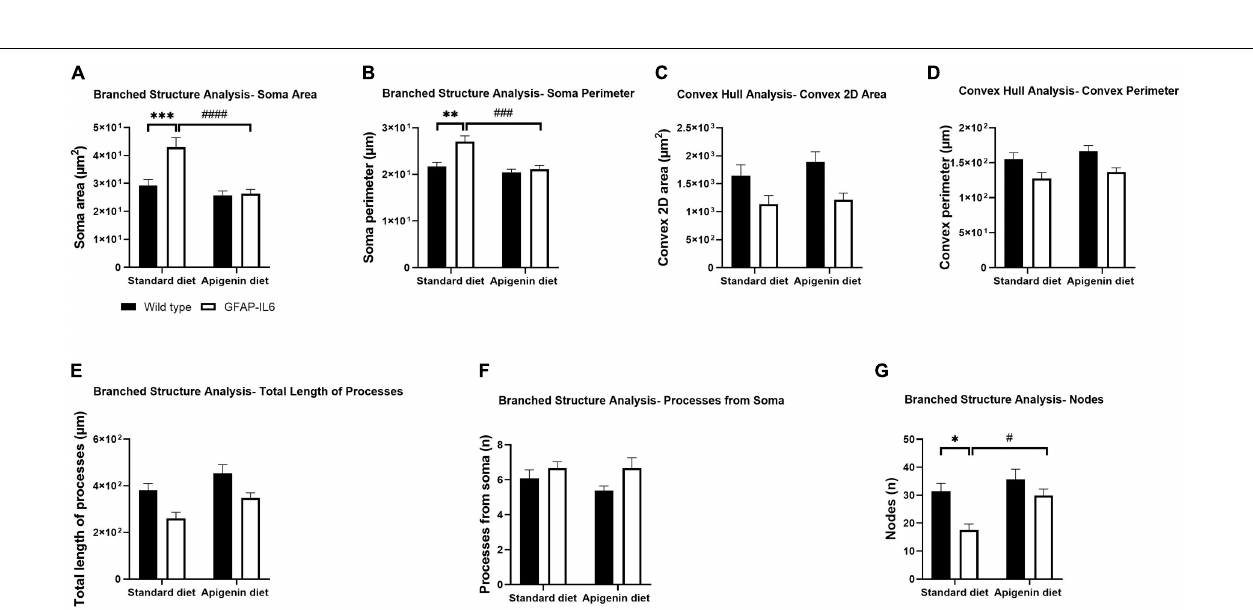
Frontiers in Neuroscience |